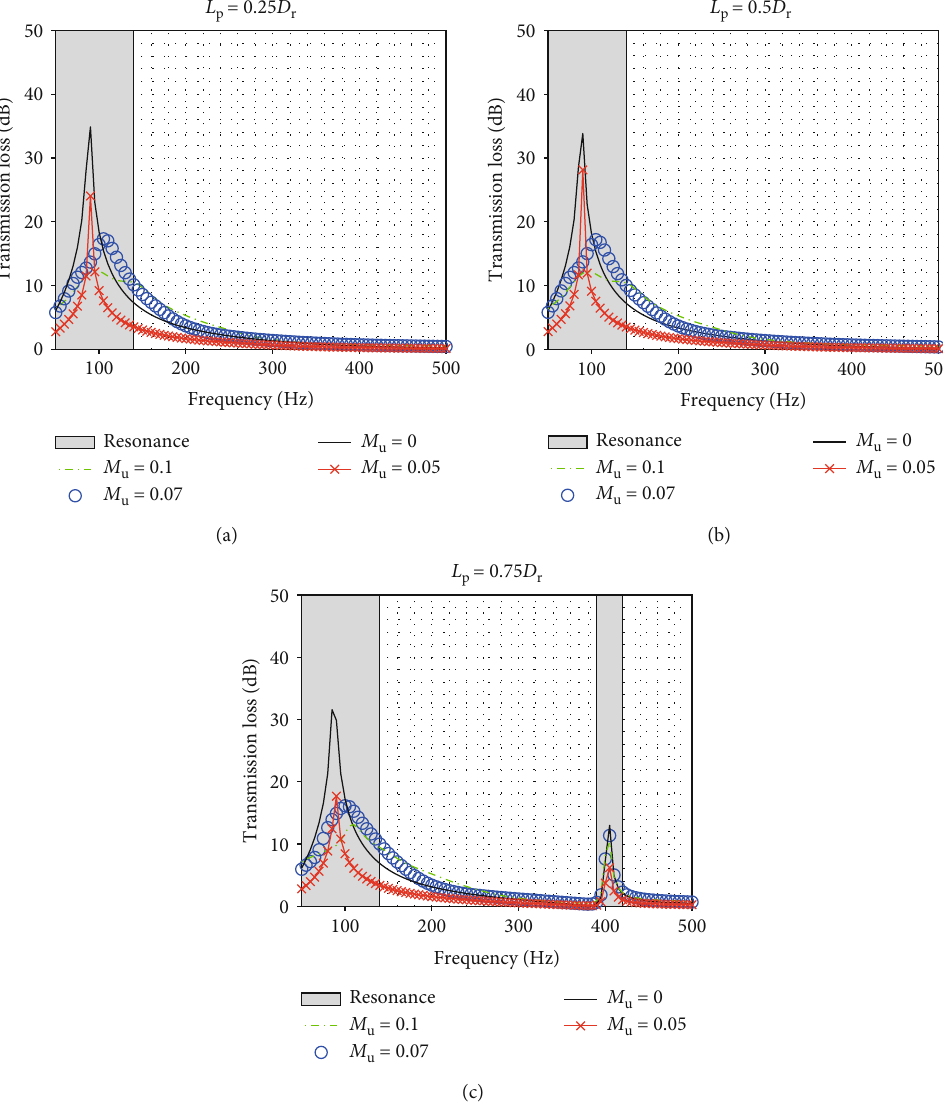
is set to 4 di ff erent values and the rigid ba ffl e is attached at H u / D = 0 : 25 , (b) L / D = 0 : 5 , and (c) L p r p r Þ /4 . The original Helmholtz resonator in the absence of the ba ffl e is r